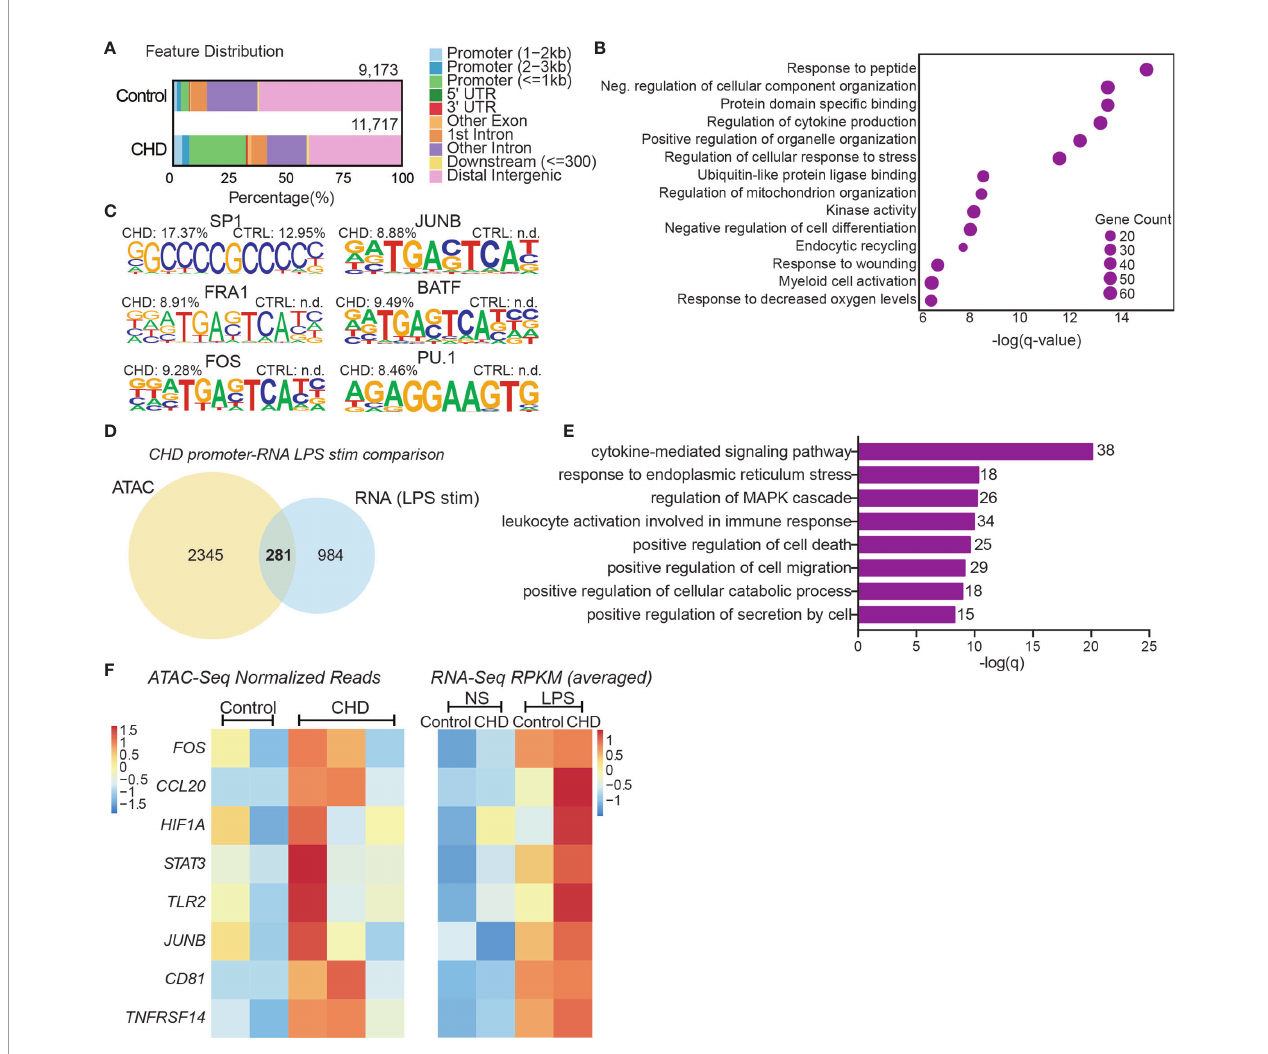
FIGURE 4 | CHD primes the monocyte epigenome for in fl ammatory response. Monocytes (n = 2 Control/3 CHD) were puri fi ed from PBMC from female macaques and subjected to ATAC-Seq analysis. (A) Bar plot showing genomic feature distribution of the open chromatin regions (fold-change ≥ 2) in control and CHD monocytes at resting state. (B) GO Biological process enrichment from Metascape of genes regulated by the open promoter regions ( ≤ 1kb, fold-change ≥ 3) in CHD monocytes. The X-axis represents -log(q-value) and the size of the dot represents the number of genes within that term. (C) Homer motif enrichment of the open chromatin regions. All listed motifs have signi fi cantly enriched binding sites in the CHD monocytes where the percentage value listed is the percentage of target sequences with that motif. (D) Venn diagram of genes regulated by the open promoter regions ( ≤ 1kb, fold-change ≥ 3) and DEG detected following LPS stimulation in the CHD monocytes. (E) GO Biological process enrichment terms from Metascape of the 281 overlapping genes from (D) . (F) Heatmaps of the normalized expression of open promoter region counts and RPKM from bulk RNA-Seq analysis for selected common